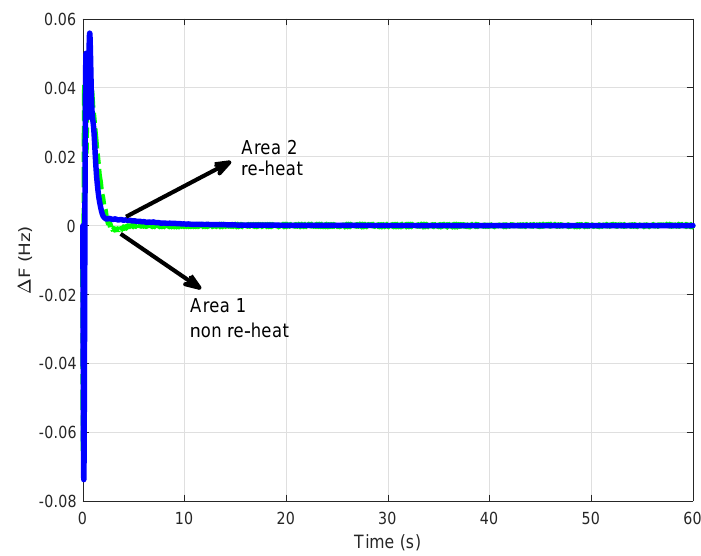
Figure 7. Frequency deviation in areas 1 and 2 with the proposed controller (case a).